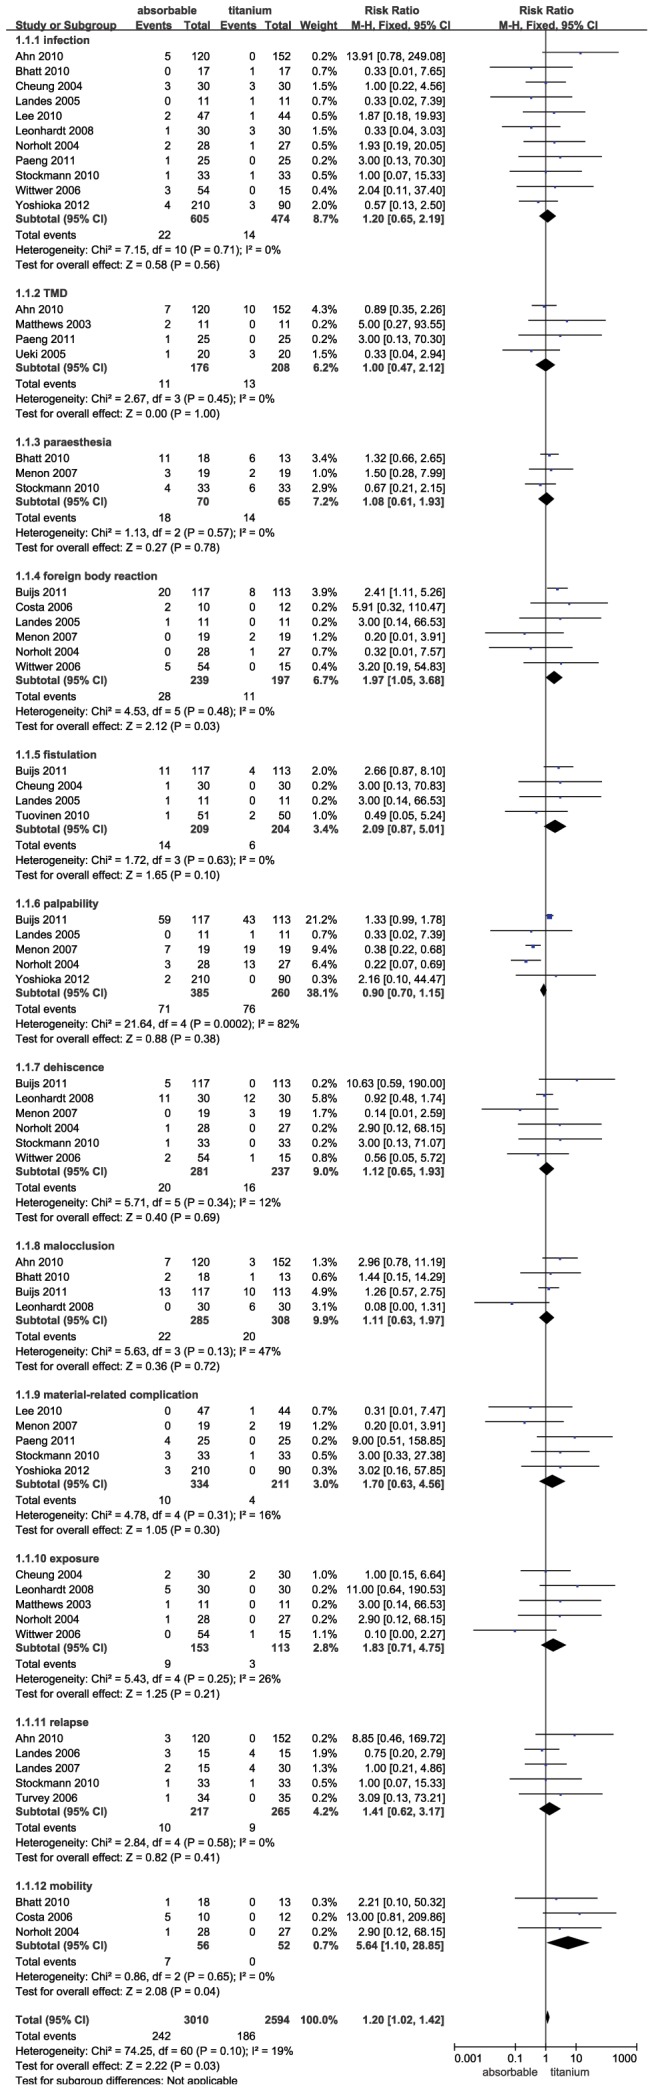
Forest plot of trials of absorbable fixation versus titanium examining the effect on relative risk of complications in all enrolled trials.TMD = temporomandibular joint dysfunction; df = degrees of freedom; M-H = Mantel-Haenszel.